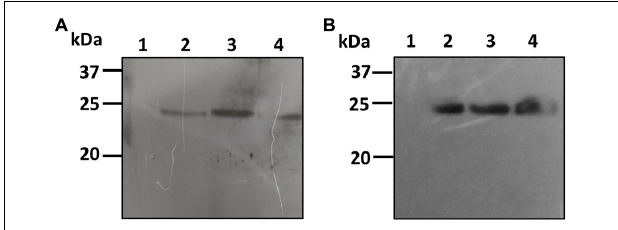
FIGURE 4 | Western blot analysis of hFGF protein expressed microalgal species. The crude proteins were extracted from Chlorella (A) and Chlamydomonas (B) and the expression of hFGF protein was analyzed on SDS-PAGE followed by Western blot probed with a rabbit anti-his antibody conjugated with HRP. Lane 1: Wild Type; Lane 2: Sample collected after 24 h of Agrobacterium transformation and cefotaxime addition; Lane 3: Sample collected after 48 h; Lane 4: Sample collected after 72